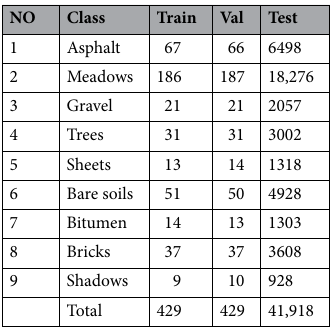
Table 3. Number of training, validation, and test samples for PU